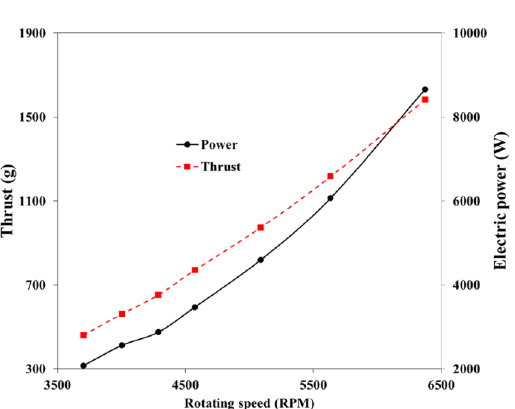
Figure 5. Required power and thrust of rotor (propeller + motor) as a function of the rotating speed which is changed by changing throttle from 50 to 100%. The data is provided by manufacturer. Figure 4. Multirotor UAV used for numerical predication and experimental validation.